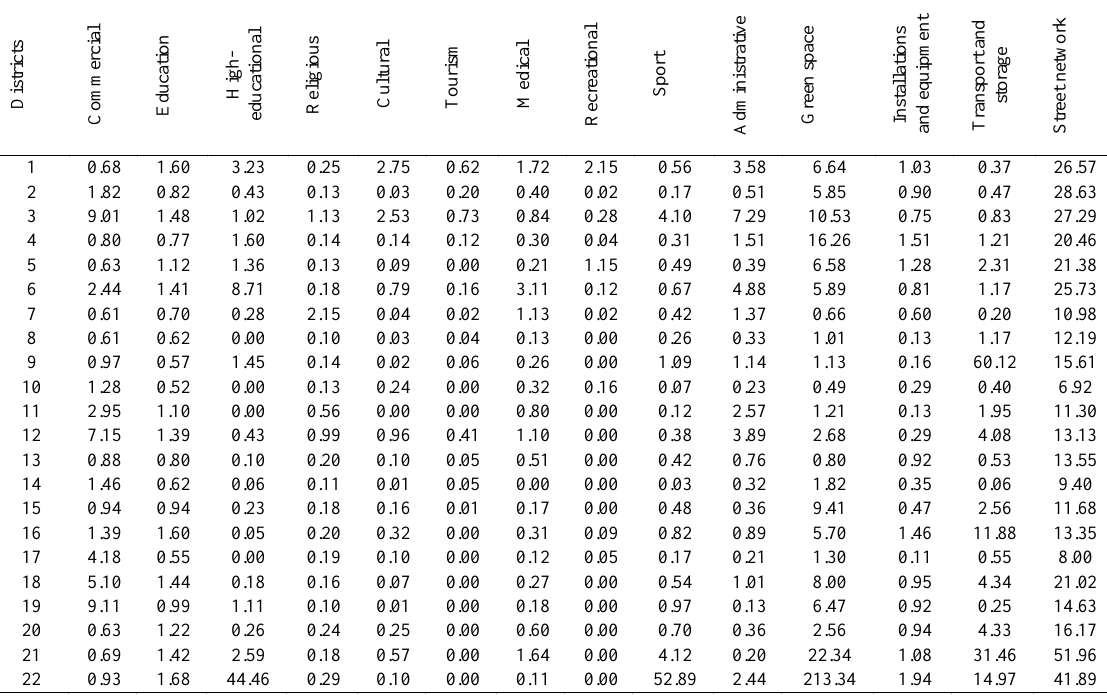
Table 1: Per capita of urban services uses in different districts of